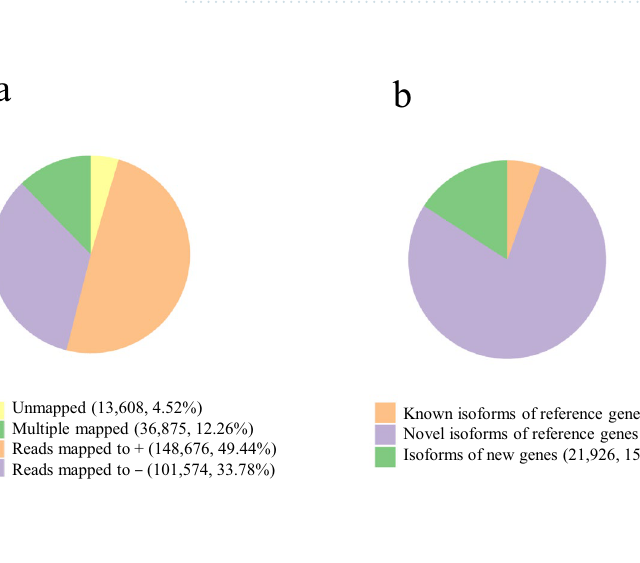
Table 1. Statistical information of PacBio Iso-Seq sequencing and processing.